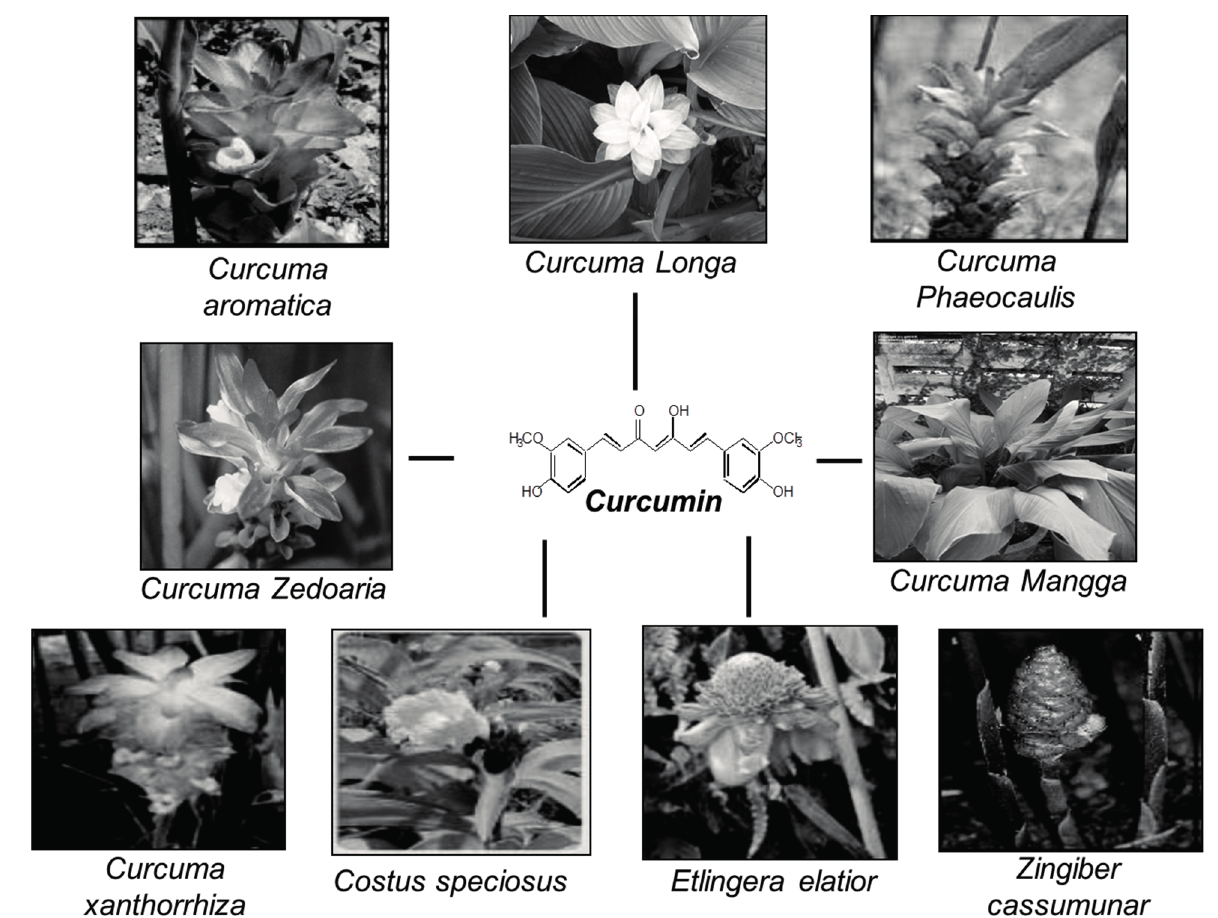
Figure 1. Biological sources and chemical structure of